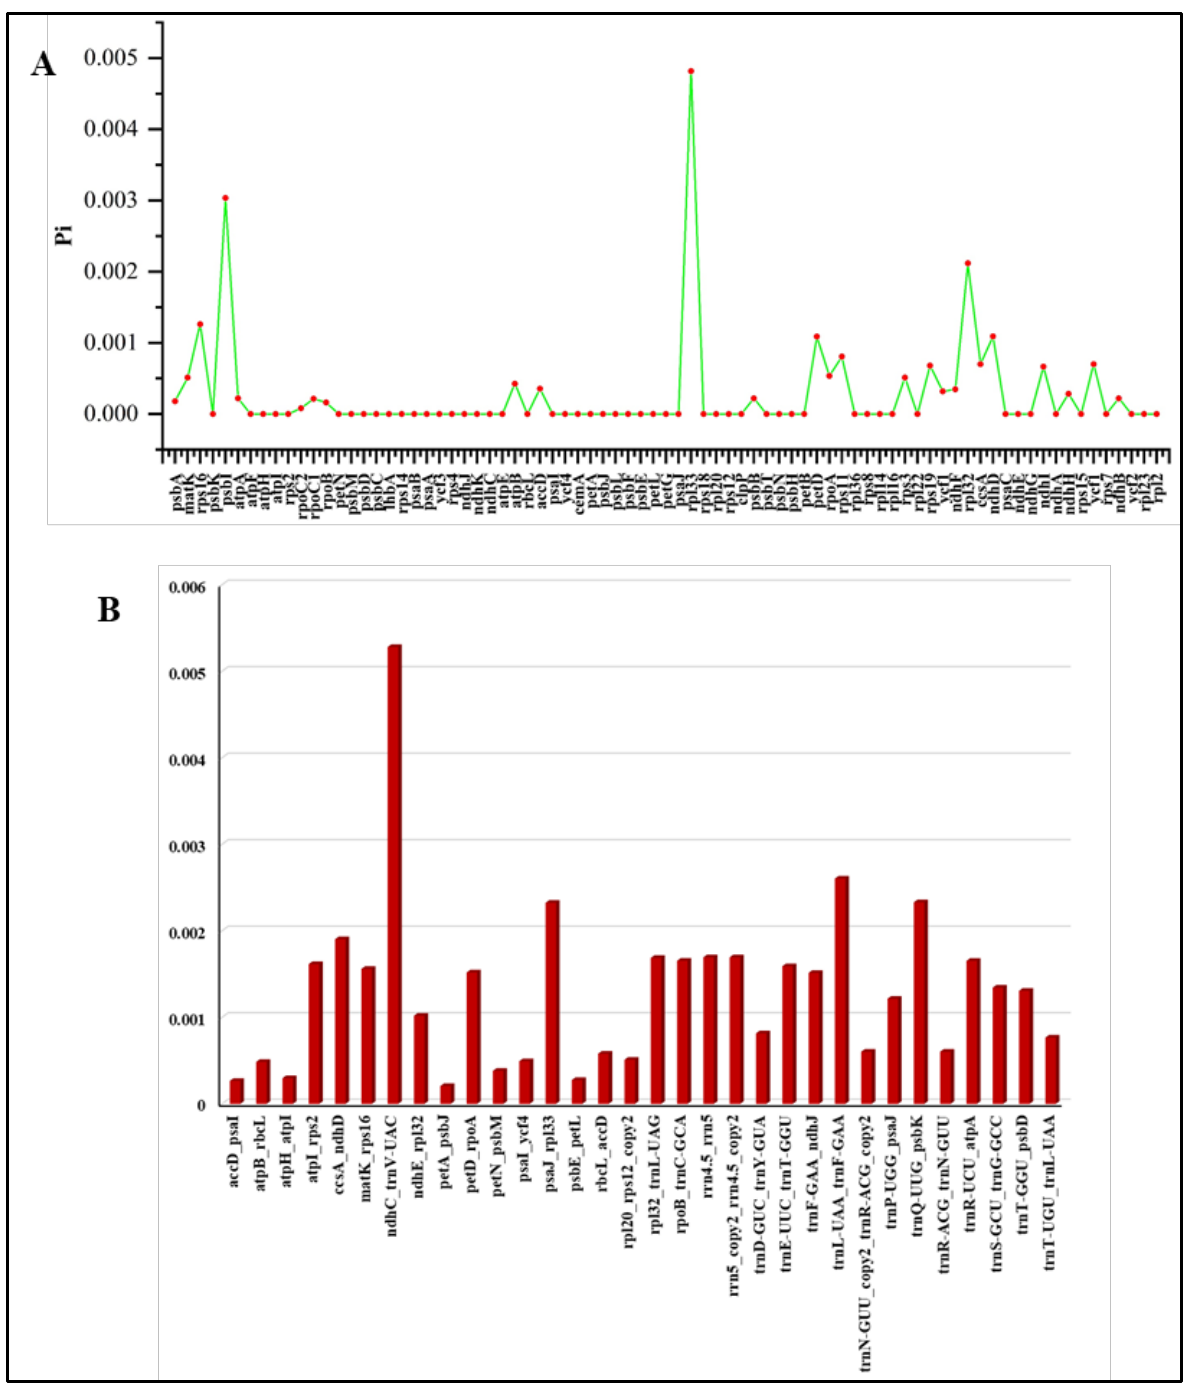
Figure 5. Comparative analysis of nucleotide diversity (Pi) values among the cp genome sequences of Prunus mume accessions. ( A ) Nucleotide diversity (Pi) values in the large single-copy (LSC) and small single-copy (SSC) trees and inverted repeat (IR) regions. ( B ) Nucleotide diversity (pi) values of intergenic regions in the LSC, SSC and IR regions. Gene nucleic acid diversity (pi) line chart. The abscissa denotes the gene name, and the ordinate denotes the pi value.